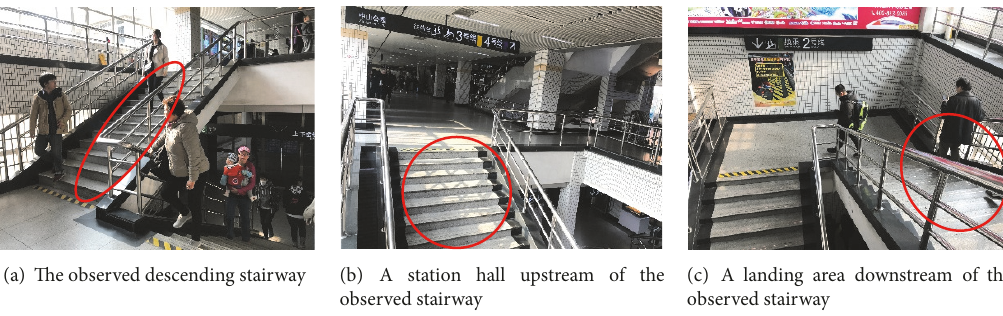
Figure 3: Details of connected landings of the observed descending stairway.